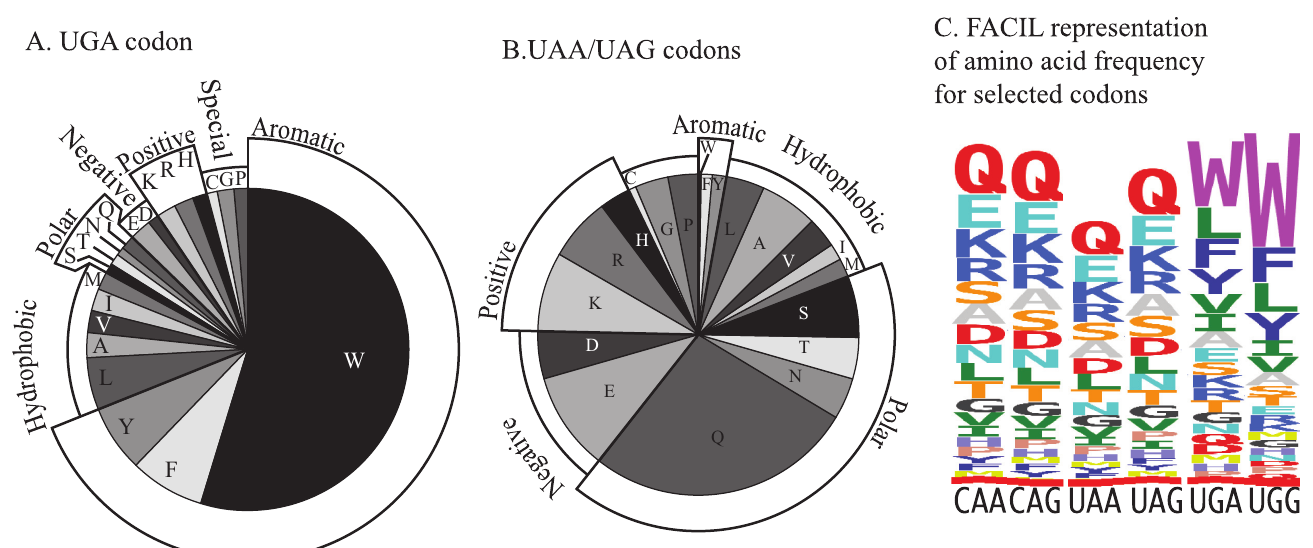
Fig 3. The amino acids aligned to UGA, UAA and UAG. A. The amino acids found in the top BLASTx alignments to the NCBI reference sequence protein database where scores were increased relative to the standard genetic code when encoding UGA as tryptophan. The amino acids are grouped into hydrophobic, polar, negative or positively charged, and special cases. The UGA commonly was aligned to gaps, but these cases are not shown here. Only alignments to tryptophan, tyrosine, or phenylalanine increase BLASTx positive alignment scores with the matrix used; however all UGA codons within sequences with increased BLASTx scores are used in this comparison. B. Amino acids associated with UAA and UAG codons in BLASTx comparisons where scores were increased when translating UAA and UAG as glutamine. Gaps were not included in this analysis. C. FACIL analysis of the genetic code. The four possible glutamine and two likely tryptophan codons are shown. The most commonly found amino acids when these codons are translated and compared to the protein family (pfam) database are shown as a sequence logo with height proportional to frequency as inferred by